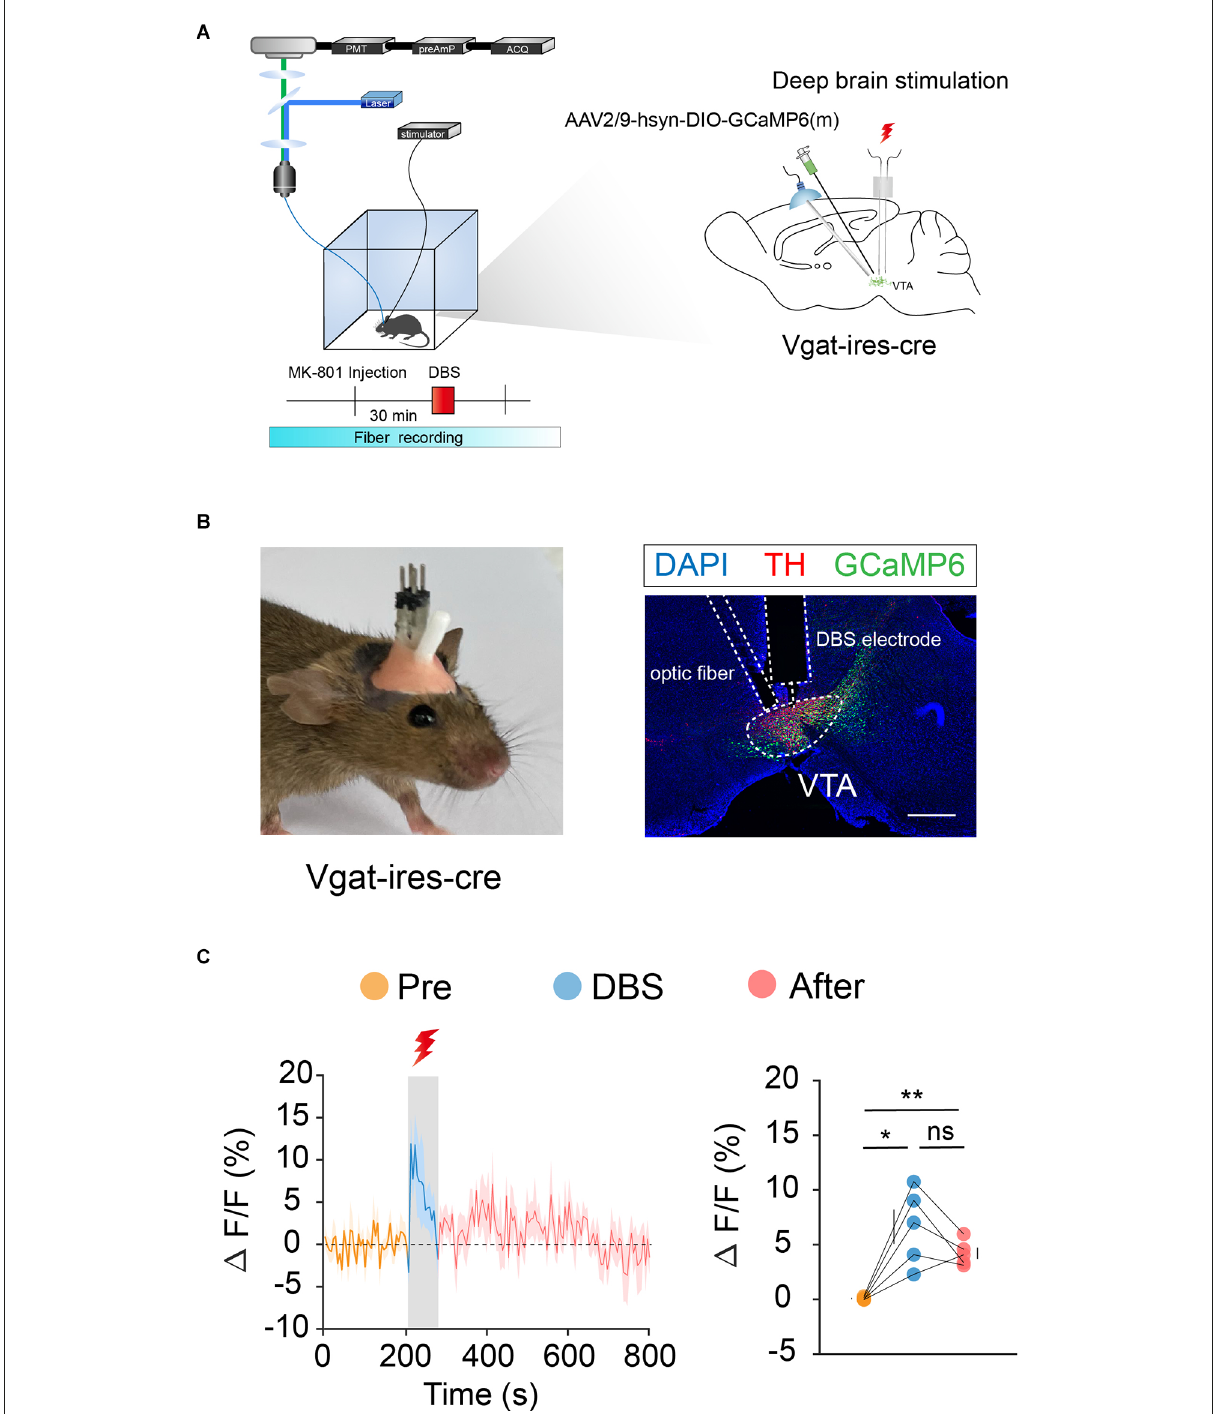
FIGURE4 DBS of the VTA activates VTA GABA neurons. (A) Left: schematic of the DBS equipment and the fiber photometry system. Right: schematic of viral injection, fiber implantation, and DBS electrode implantation in Vgat-ires-cre mice. (B) Left: actual view of the electrode and the fiber on the head of a Vgat-ires-cre mouse. Right: successful expression of GCaMP6m in VTA GABA neurons. White dashed lines indicate the location of the DBS electrode and fiber above the VTA. The image shows GCaMP6m+ cell bodies (green) and TH+ neurons (red) in Vgat-ires-cre mice. Scale bar, 300 µ m. TH, tyrosine hydroxylase. (C) GCaMP6m signals from VTA GABA neurons show that DBS of the VTA activates VTA GABA neurons immediately and they remain active for a period of time after the stimulus has stopped. * p < 0.05, ** p < 0.01; ns, no significance. one-way ANOVA. All error bars represent ± SEM. n = 5